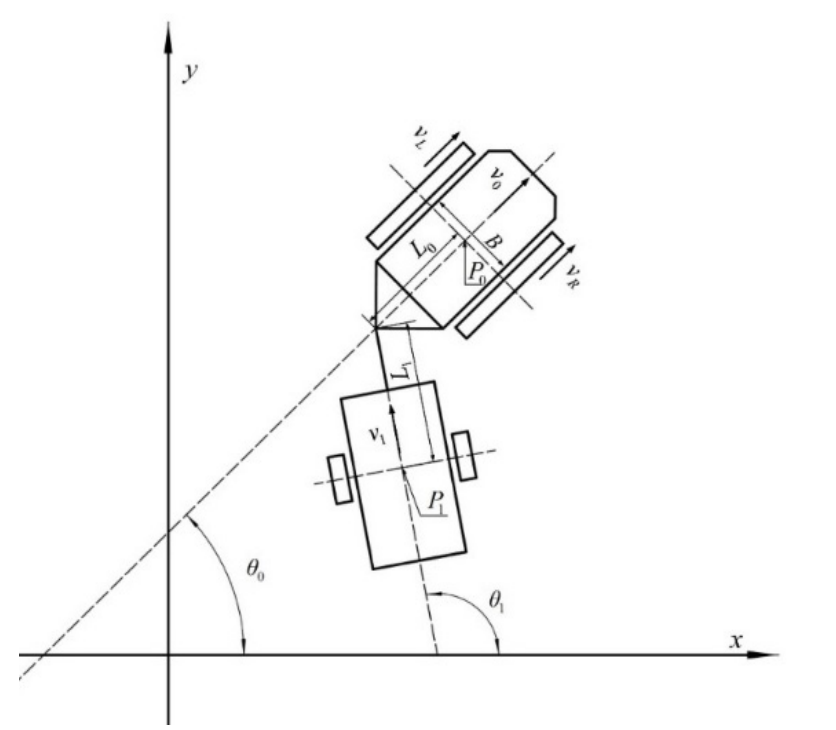
Figure 3. Kinematic model of the orchard traction spraying robot. According to the kinematic principle, the expression for the position information of the spraying trailer is shown in Equation (4). on the left and right sides of the tractor are related as in Equations (1) and (2).